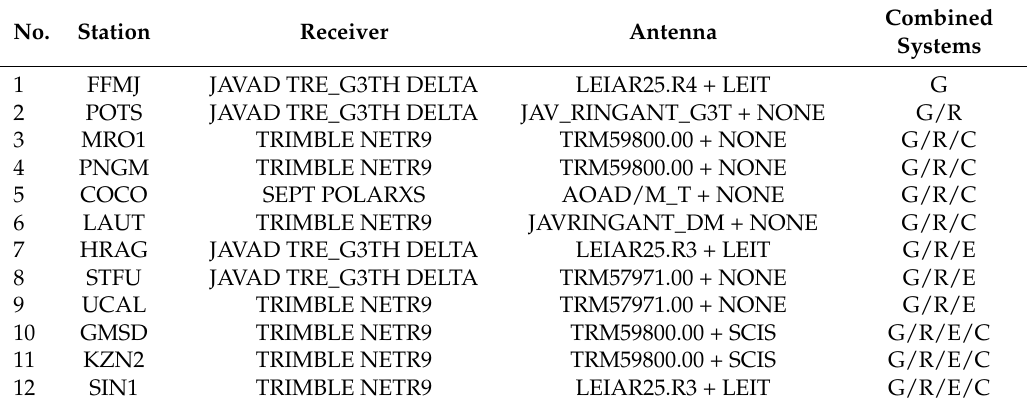
Table 4. Station information for the accuracy test of real-time